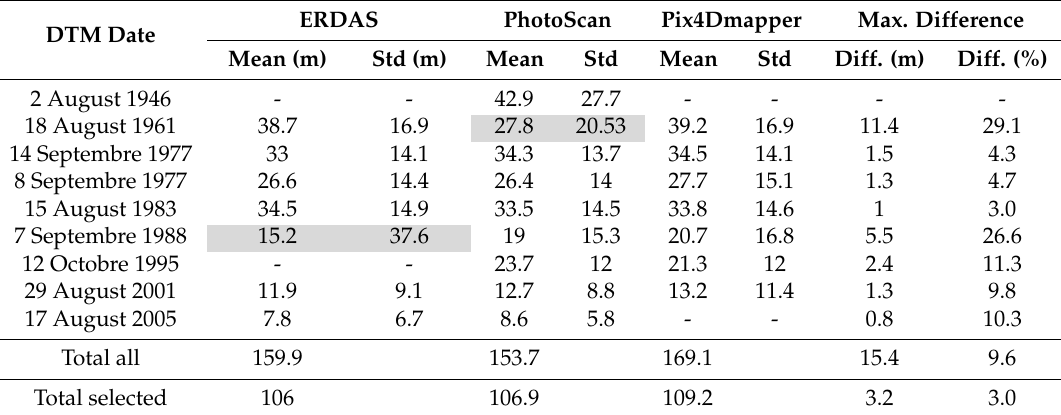
Table 4. Mean elevation difference (dH) of the overlapping glacier areas from the DTM difference between the reference DTM and the DTM of the respective date and software. “Total all” shows the sum of dH values where all three software packages yield results. “Total selected” sums up only the DTMs with sufficient quality for further